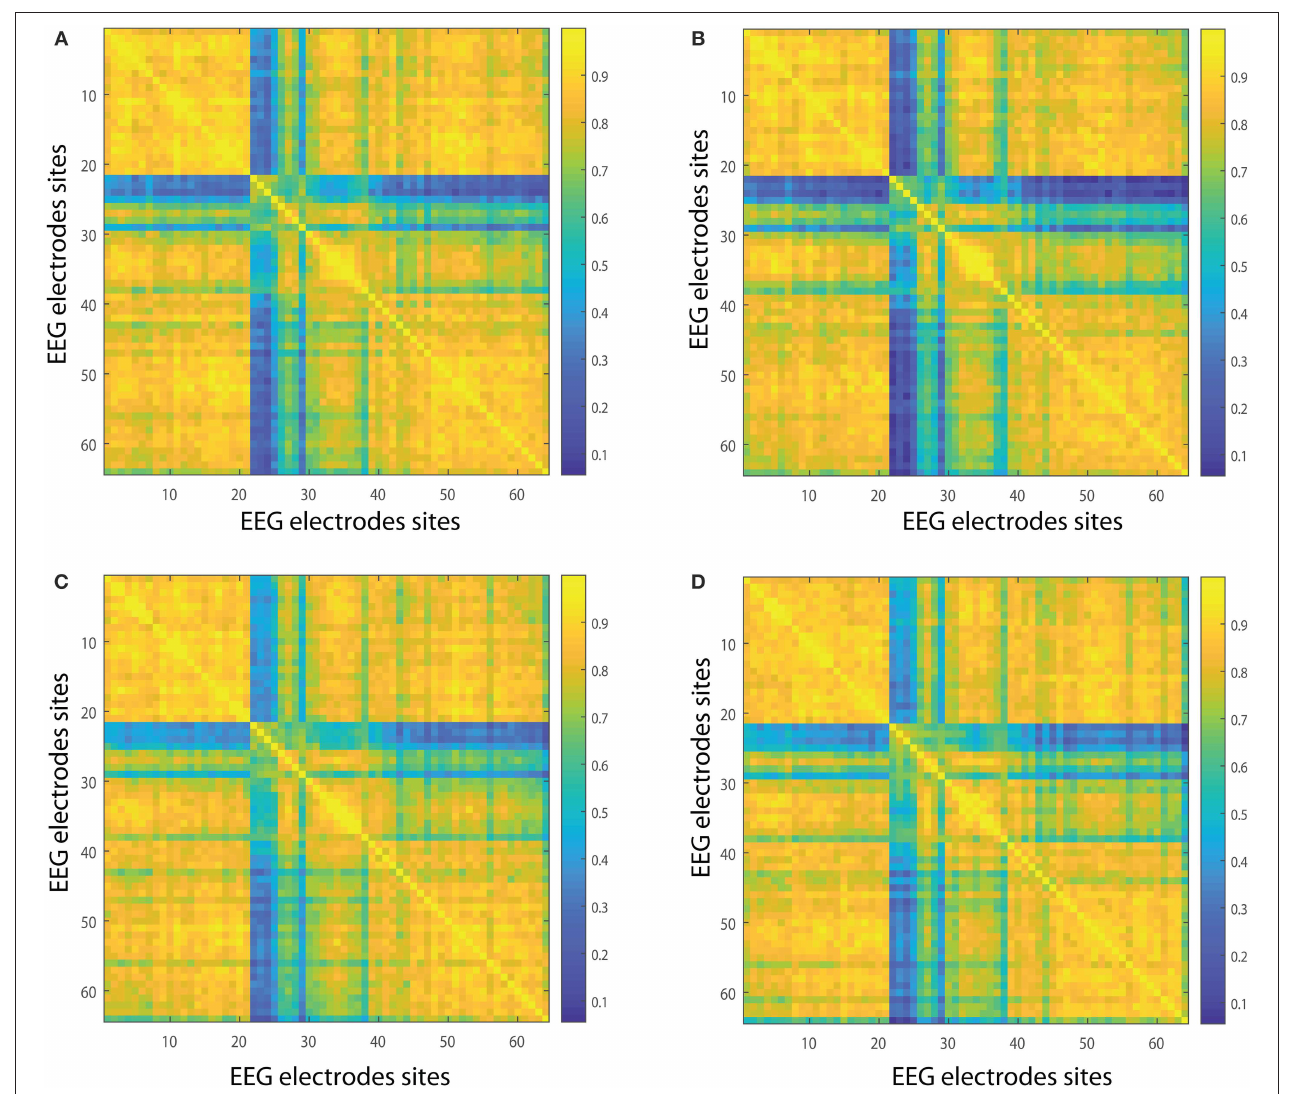
FIGURE 3 | Network interconnectivity. (A,B) Show the network averaged values of the interconnectivity considering 109 subjects when performing the visuomotor task for the 64-channel EEG considering the different oscillation bands alpha 1 and alpha 2. (C,D) Are the same as (A,B) but considering the imagined task. We consider D = 6 and τ = 1. Alpha 1 oscillation band corresponds to [8,10) Hz and alpha 2 oscillation band to [10,13) Hz .